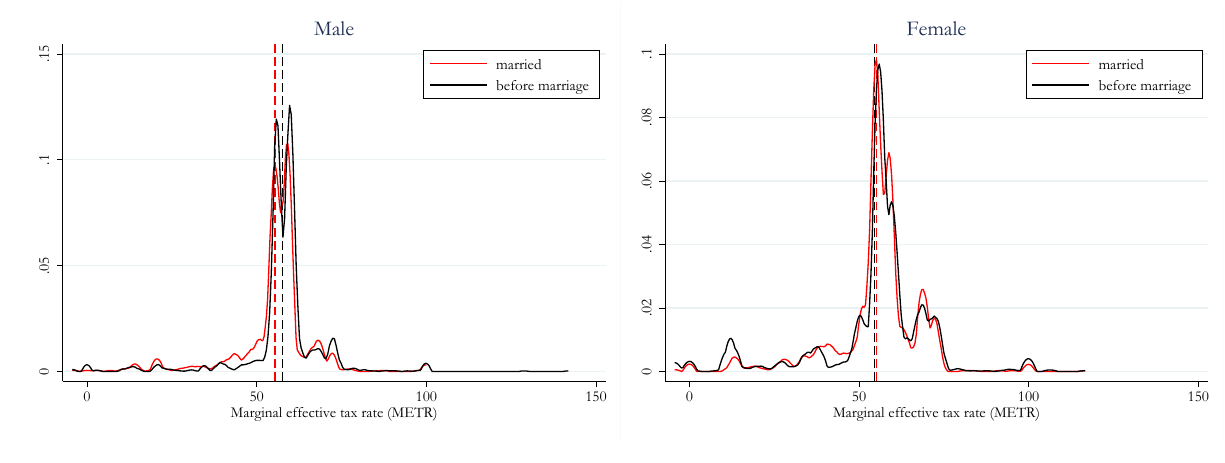
Figure A1. METRs in